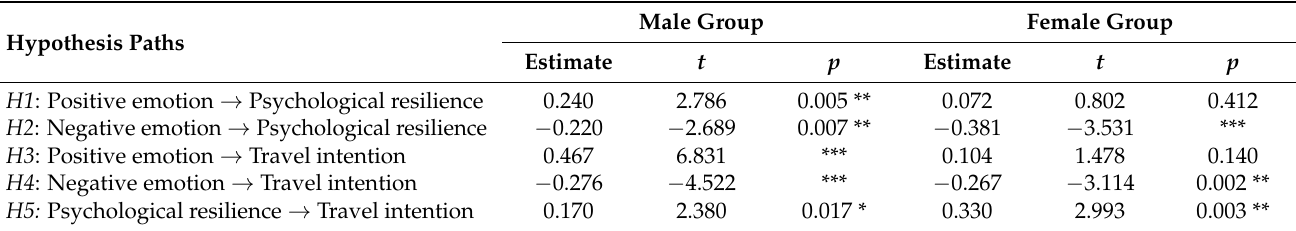
Table 6. The moderating effect of